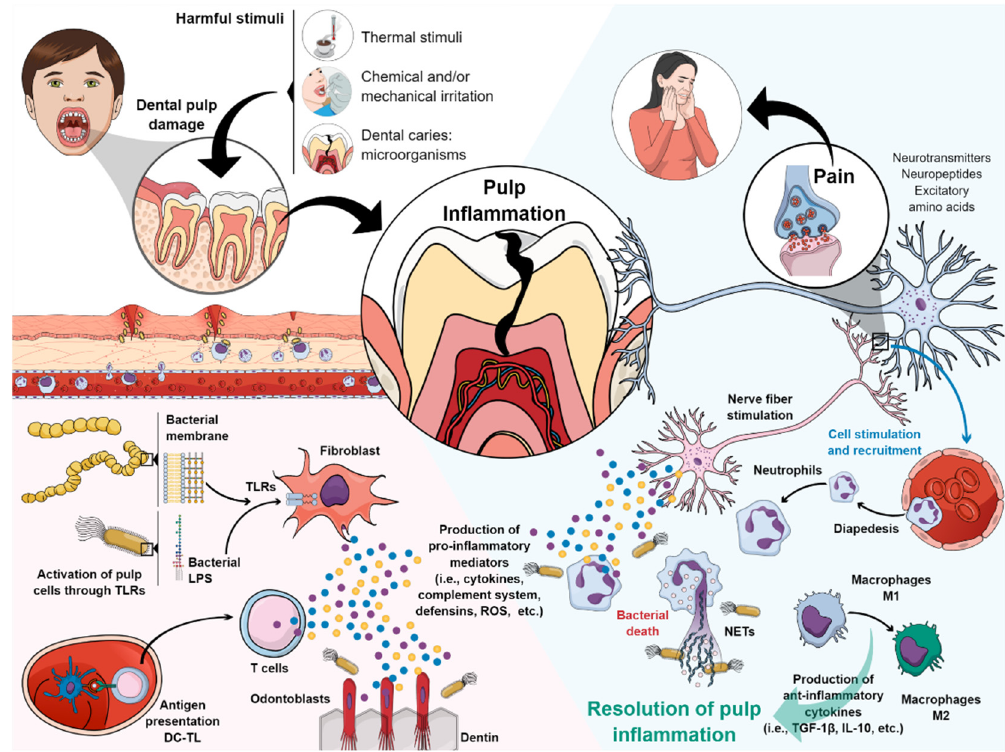
Figure 1. Inflammatory response of the pulp tissue. Explanation in the text. Figure created in MindtheGraph by Muñoz- Carrillo et al., 2021.